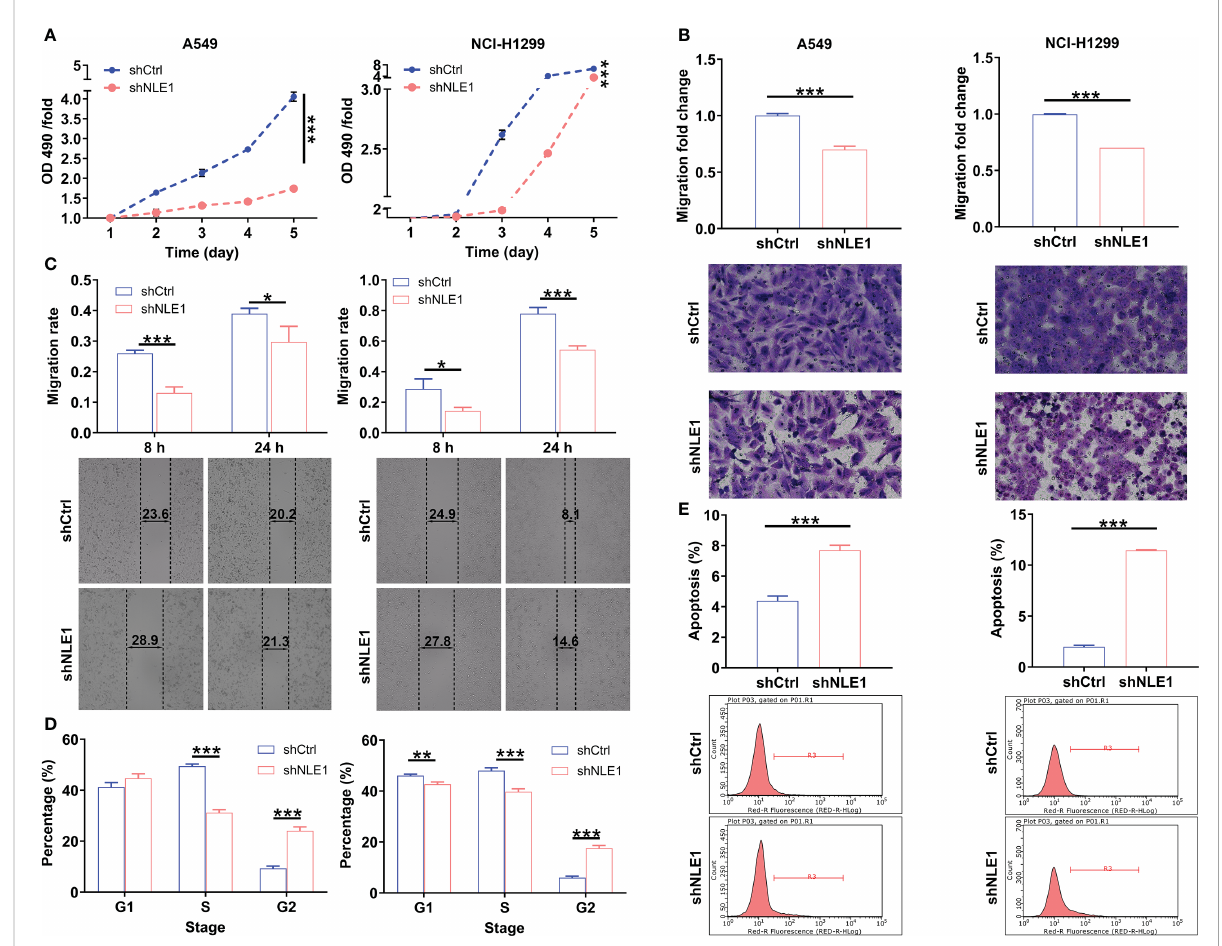
FIGURE 2 The effects of NLE1 knockdown on non-small cell lung cancer cell phenotypes. (A) The cell proliferation levels of A549 and NCI-H1299 cells were assessed after infecting lentiviruses by MTT assay. (B, C) The cell migration abilities of A549 and NCI-H1299 cells were evaluated after infecting lentiviruses by transwell assay (B) and wound-healing assay (C) . Magni fi cation times: 200×. (D) The effects of NLE1 knockdown on cell cycle of A549 and NCI-H1299 cells were determined by fl ow cytometry. (E) The effects of NLE1 knockdown on cell apoptosis of A549 and NCI- H1299 cells were examined by fl ow cytometry. Results were presented as mean ± SD (n ≥ 3). * P < 0.05, ** P < 0.01, *** P <